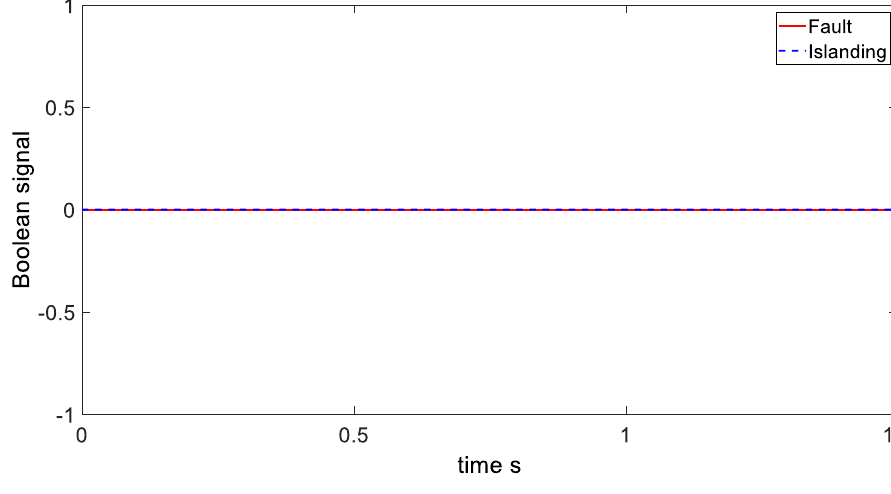
Figure 16. Non-detection zone (NDZ) of the proposed islanding detection technique. 5. Conclusions A new passive islanding detection technique for inverter-based DGs was proposed and investigated in this paper. The developed method is based on the rate of change of voltage (RoCoV) and the ratio of voltage and current magnitudes (VoI) at PoC in order to detect all kind of events and distinguish them from islanding condition. The main ad- vantages of the proposed method are: (1) It is quick enough to detect an islanding event in less than 2 s, which is a requirement according to IEEE Std. 1547-2018. (2) The NDZ is narrow when compared to other traditional passive methods. (3) It has a decentralized operation principle, which may simplify and reduce the cost of implementation. (4) It is compatible with traditionally used distribution network infrastructures. (5) It is robust robust against system short circuit faults and load switching, as well as both stable and unstable power swings.